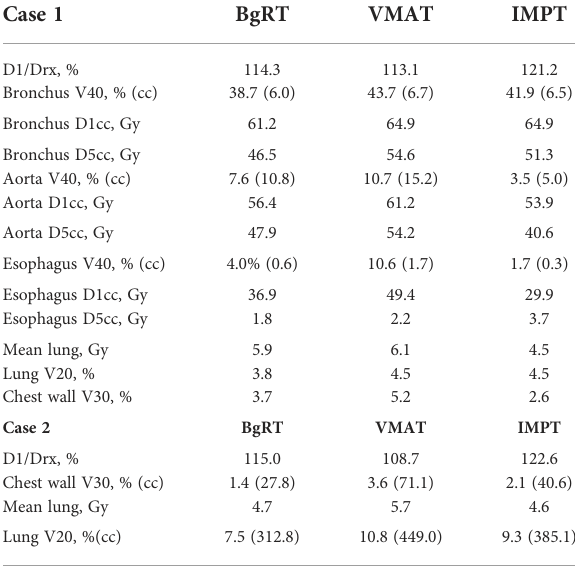
TABLE 1 Dose – volume statistics for the two clinical